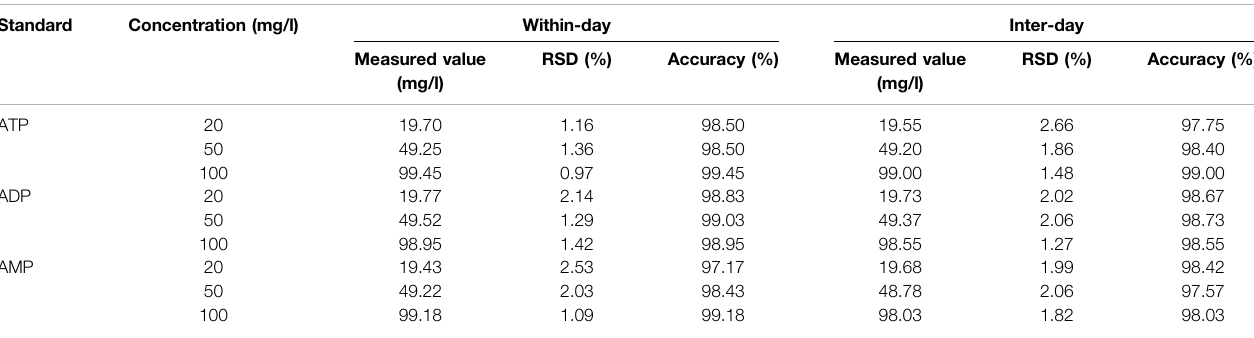
TABLE 2 | Precision and accuracy (n (cid:2)